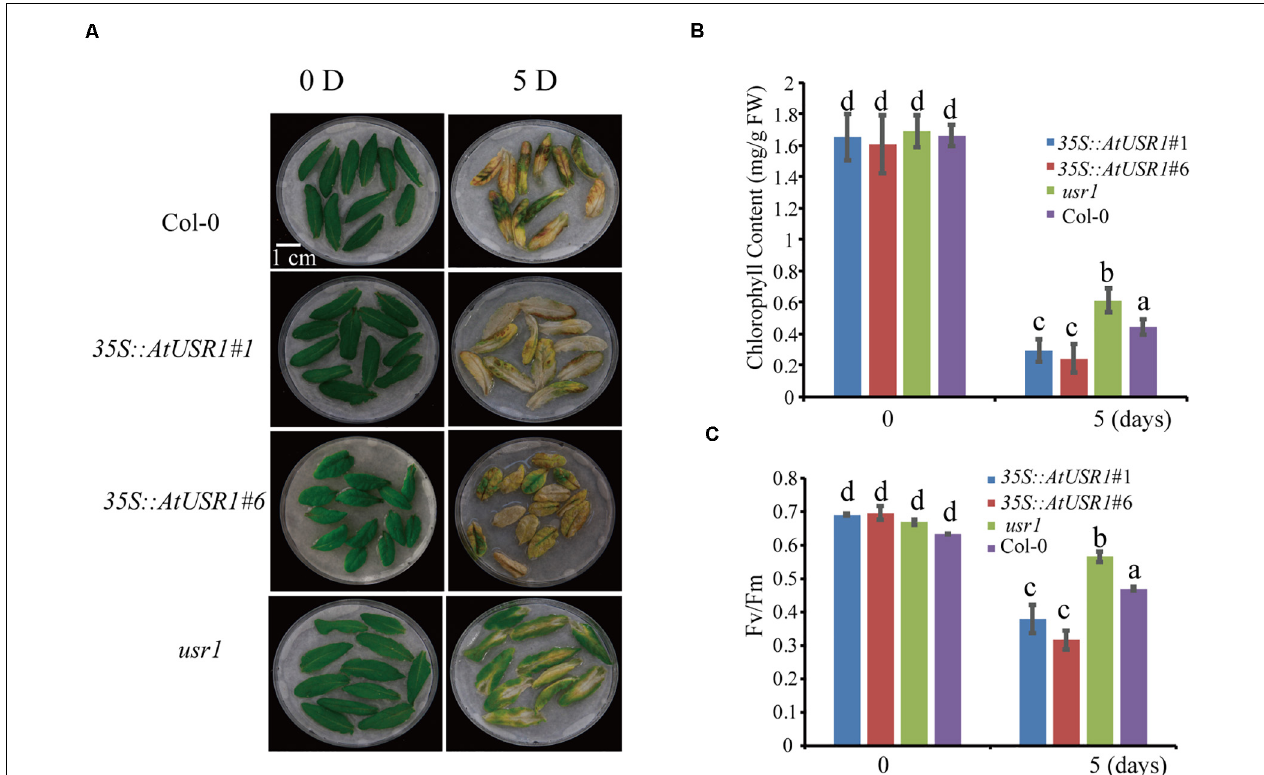
FIGURE 6 | AtUSR1 plays as positive role in JA mediated leaf senescence. (A) AtUSR1 overexpression enhanced JA-induced leaf senescence while usr1 mutation delayed this process. Detached Sixth leaves of different genotypes were treated with 50 µ M MeJA for 5 days. (B,C) Total chlorophyll content and Fv/Fm in the leaf samples of different genotypes as indicated. The data in (B,C) different letters above columns indicate significant differences according to Duncan’s multiple range test ( P < 0.05). Data are shown as the mean ± SD from three independent